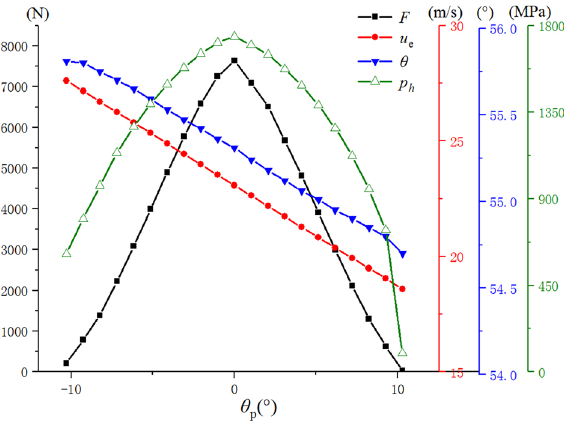
Figure 4. Contact load, lubricant entraining velocity and angle changing with the meshing